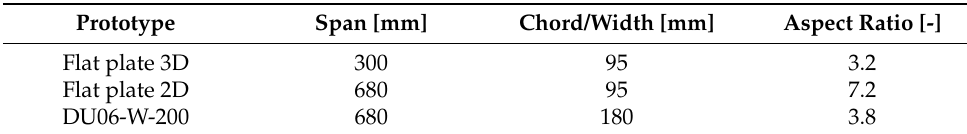
Table 1. Tested prototypes and